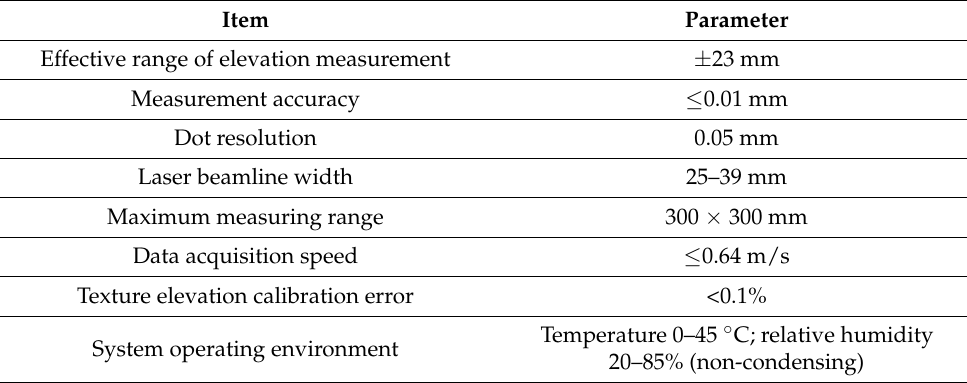
Table 9. The parameters of the pavement anti-slip texture tester.